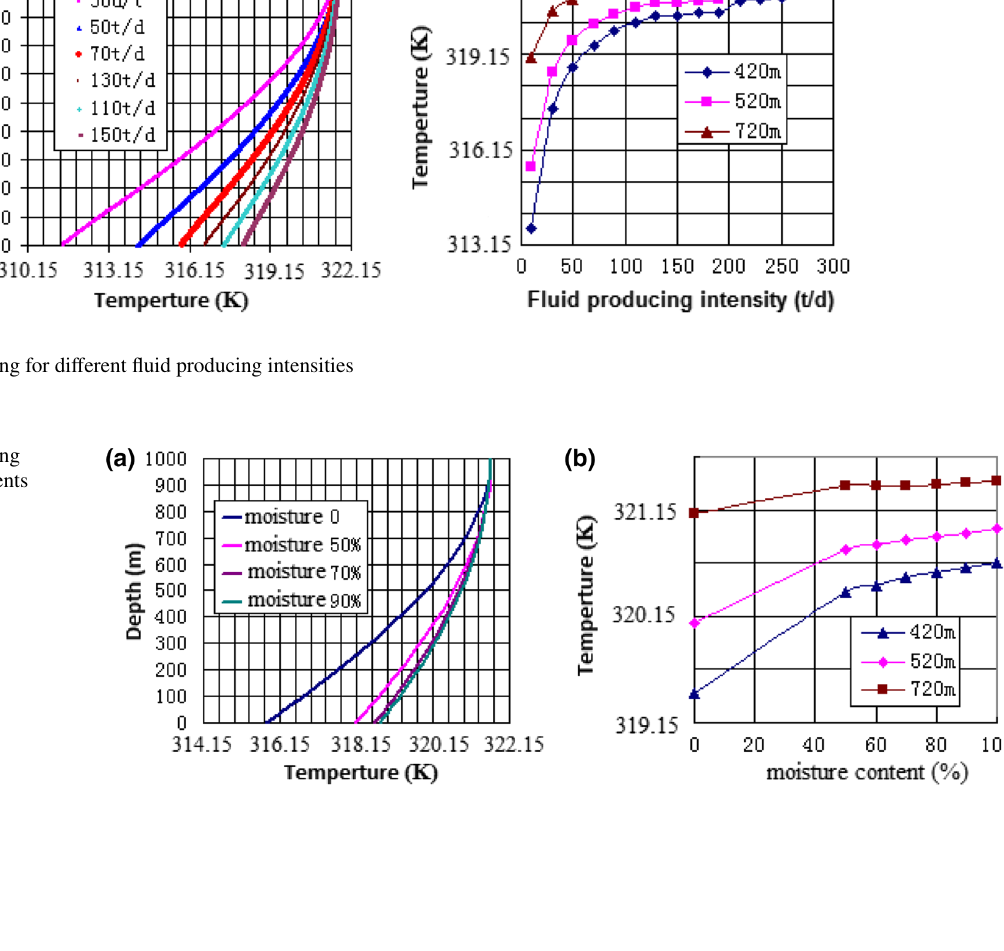
Fig. 7 Apparatus, relation of viscosity and